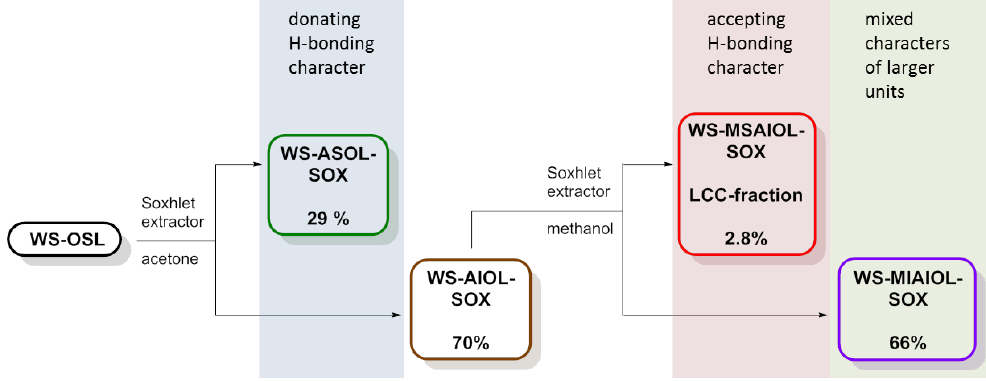
Figure 2. Flow of Soxhlet-based WS-OSL fractionation, leading to, among others, the LCC-fraction as the methanol soluble part of the acetone insoluble fraction ( WS-MSAIOL-SOX ). Table 1. Yields and molecular mass key characteristics of WS-OSL and Soxhlet-derived Obtained fractions were analysed for molecular mass and structural characteristics using gel